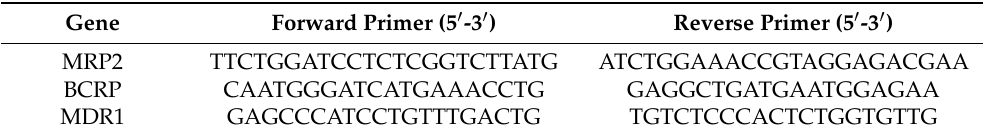
Table 1. Sequences of primers used for RT-PCR analysis. Gene Forward Primer (5 (cid:48) -3 (cid:48)